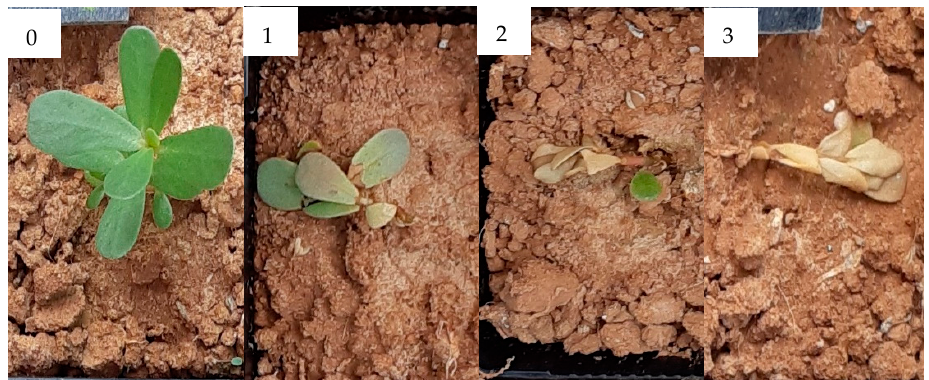
Figure 14. Damage level scale of Echinochloa crus-galli. 0 Undamaged plant, 1 Plant with slight damage, 2 Plant with severe damage, 3 Critically damaged plant, 4 Dead plant.